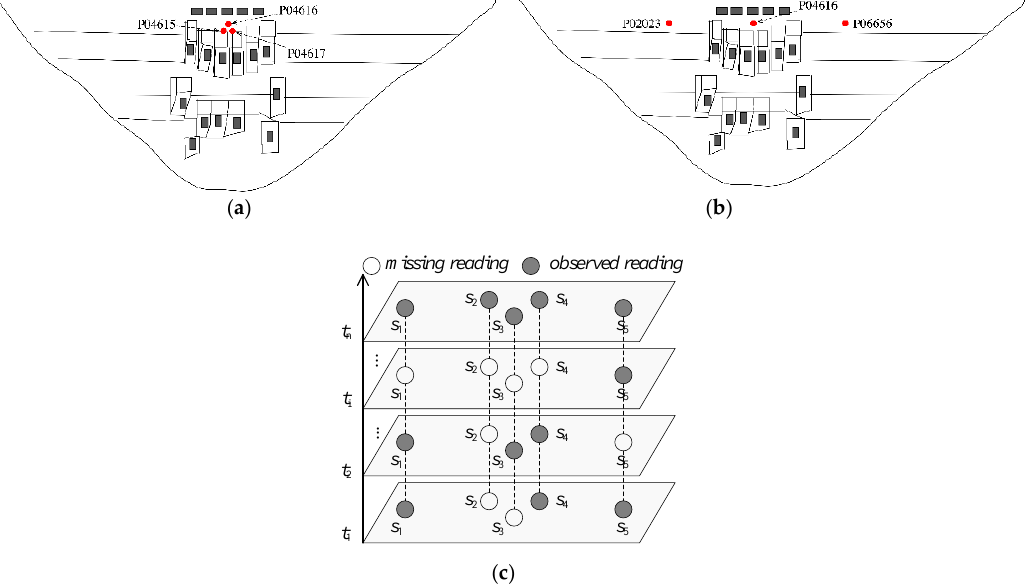
Figure 1. From Figure 1a,b, three sensors P04616, P04615, P04617 are closely deployed in the spatial